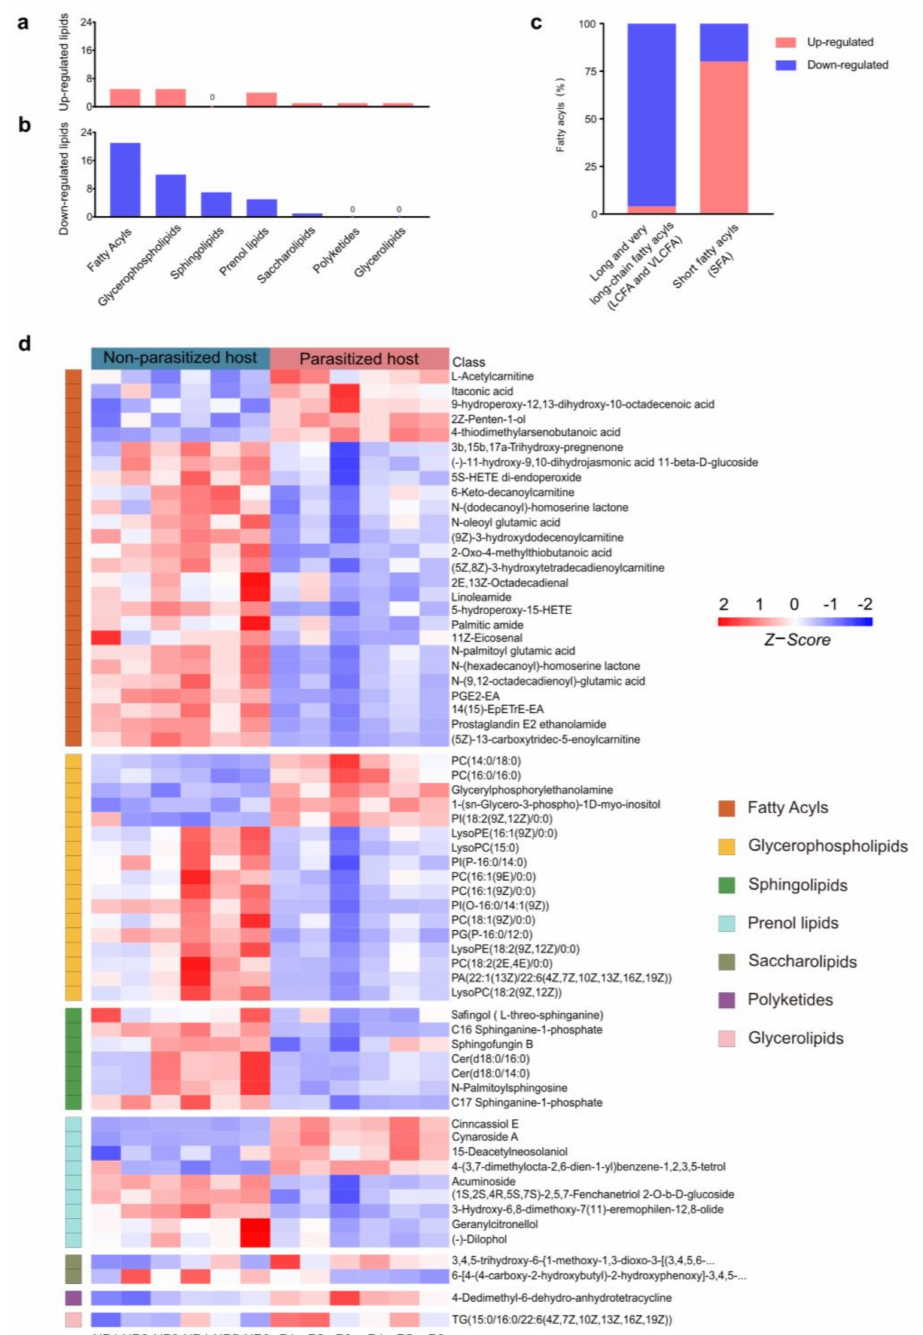
Figure 3. Differences in lipids and lipid-like molecules post A. japonica parasitization. ( a ) The classification of upregulated lipids and lipid-like molecules. ( b ) The classification of downregulated lipids and lipid-like molecules. ( c ) Distribution of differential long-chain fatty acyls (LCFAs) or very long-chain fatty acyls (VLCFAs) and short fatty acyls (SFAs) in the classification of fatty acyls (FAs). ( d ) Heatmap for comparison of lipids and lipid-like molecules between parasitized and non- parasitized hosts. Each column represents one NP or P sample, and each row represents one differentially expressed metabolite. The Z-score of each sample is plotted according to the red–blue color scale. The red and blue colors indicate high abundance and low abundance, respectively. Abbreviations: NP, non-parasitized host; P, parasitized